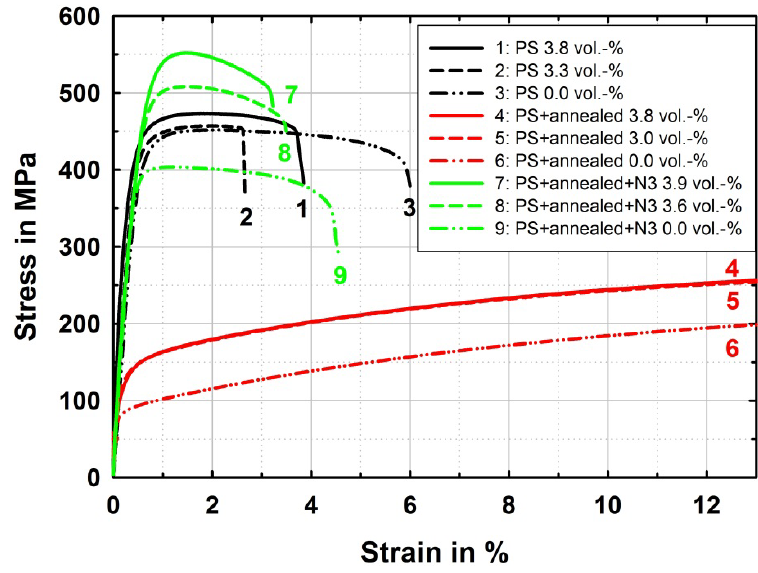
Figure 6. Stress-strain data of OFHC-Cu reinforced with different selected amounts of aluminum particles in different microstructural states. Particle strengthened after nine ARB cycles (PS), solution annealed in a further process step (PS + annealed) and after a further three ARB cycles (PS + annealed +